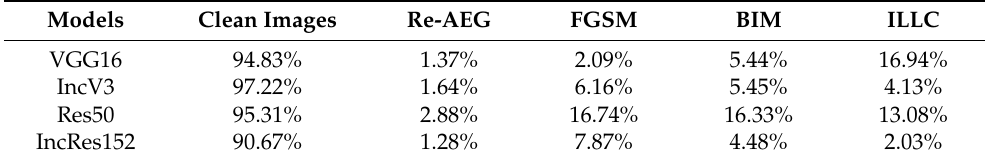
Table 1. Detection accuracy of different models.